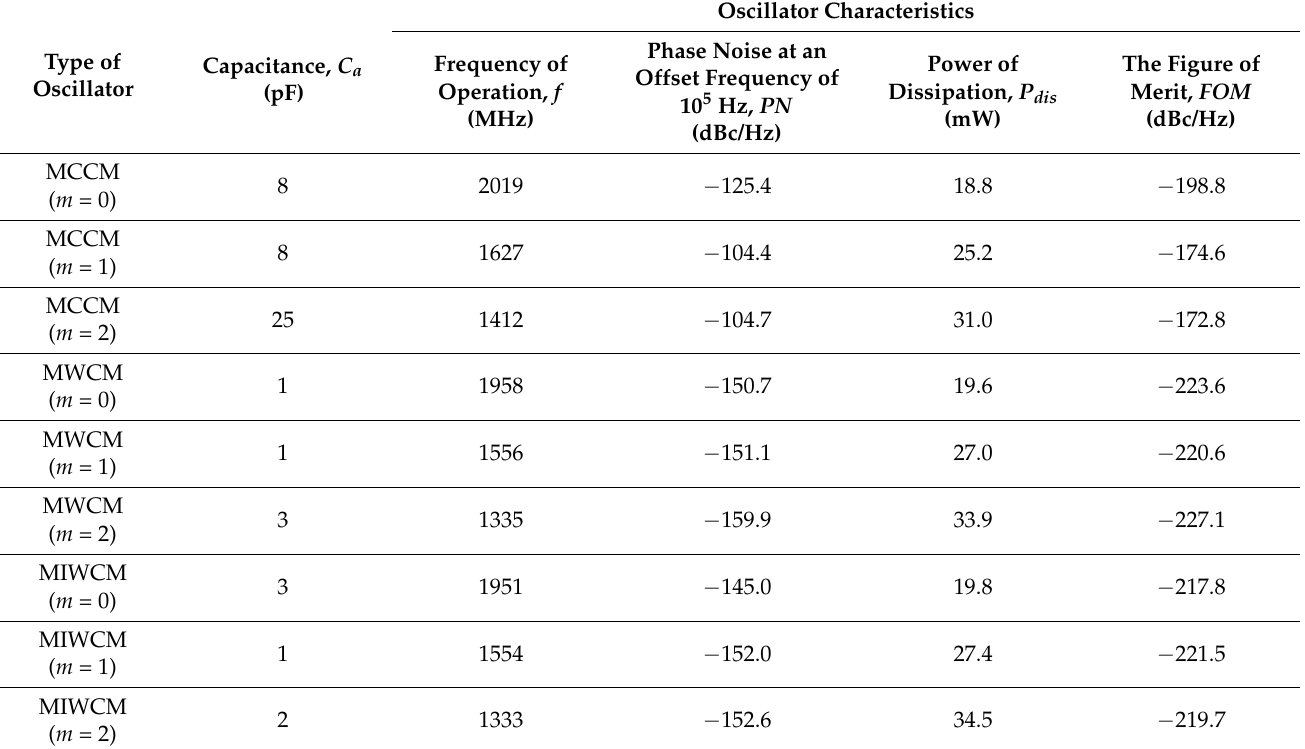
Table 8. Simulated characteristics of different NDR oscillators when R L = ∞